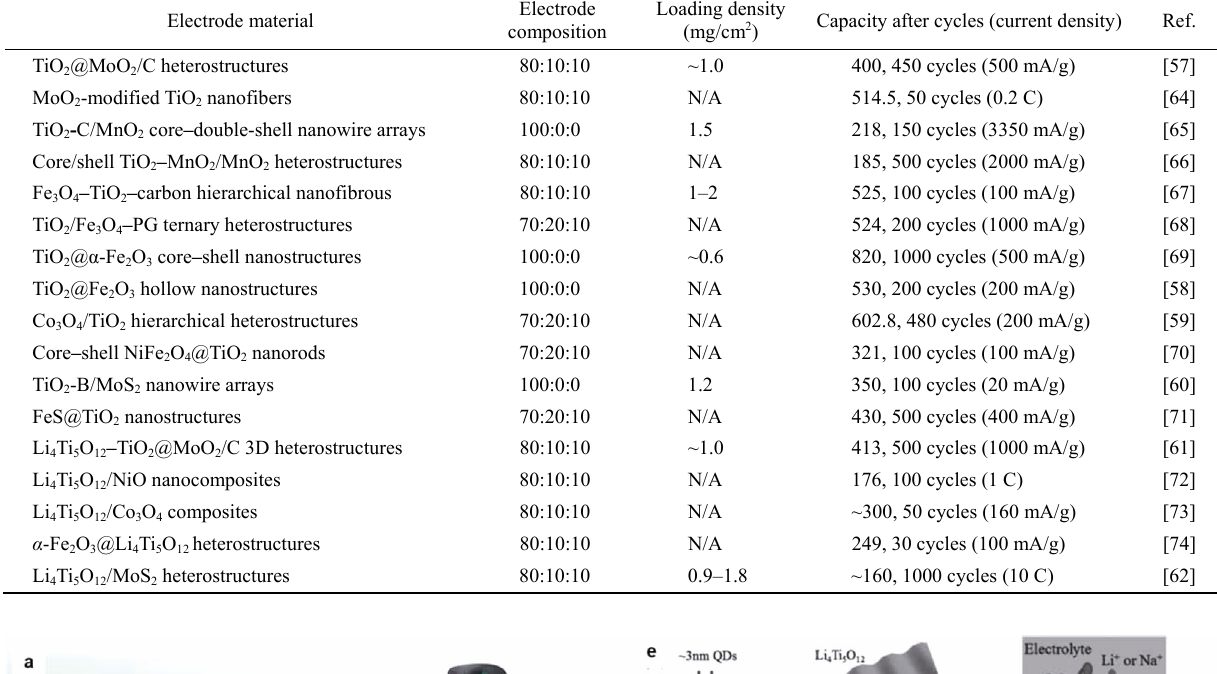
Table 1 Comparison of the electrochemical performances of Ti-based hybrid nanocomposites with conversion-type anodes. Their electrode compositions are listed using the mass ratio of active materials: conductive carbon: binder Electrode Loading density Electrode material Capacity after cycles (current density) Ref. composition (mg/cm 2 ) TiO 2 @MoO 2 /C heterostructures